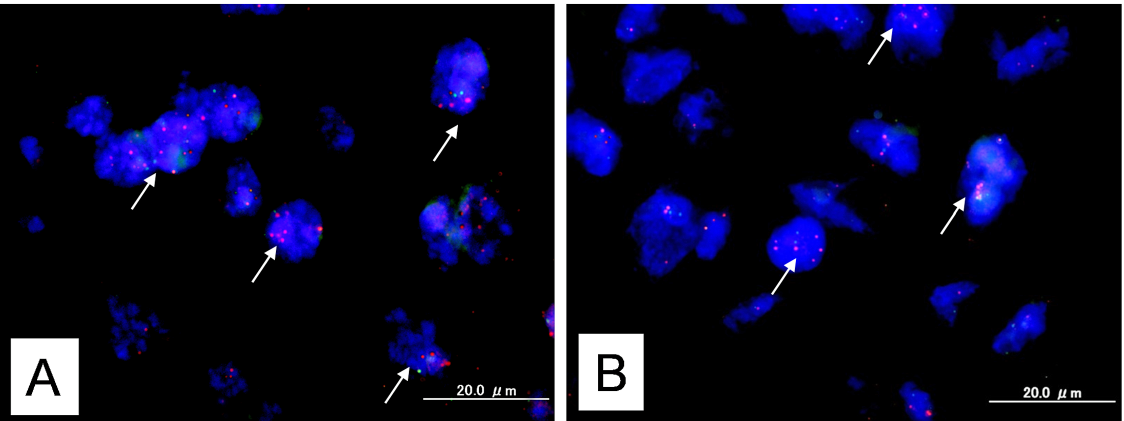
Figure 1. Dual-color fluorescence in situ hybridization (FISH) validates amplification of the KRAS or MAPK1 gene in type II ovarian carcinoma. ( A ) FISH analysis of KRAS showed a homogeneously stained region in a tumor with gene amplification. White arrows indicated amplification of KRAS gene; ( B ) FISH analysis of MAPK1 showed a homogeneously stained region in a tumor with gene amplification. White arrows indicated amplification of MAPK1 gene; ( C ) Intense immunoreactivity toward p-ERK was present in both the nuclei and cytoplasm of carcinoma cells; ( D ) This sample shows negative case of staining for